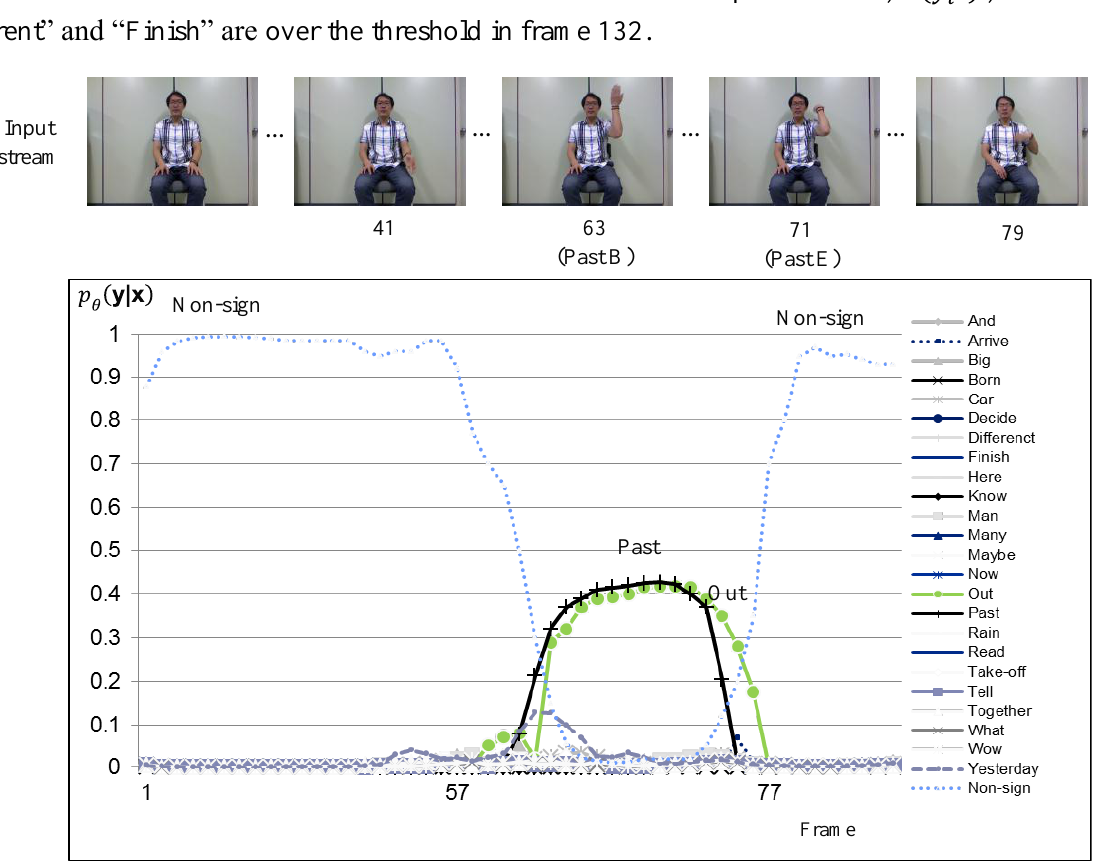
Figure 6. Sign language recognition result for H-CRF 𝟐𝑫 using a signed